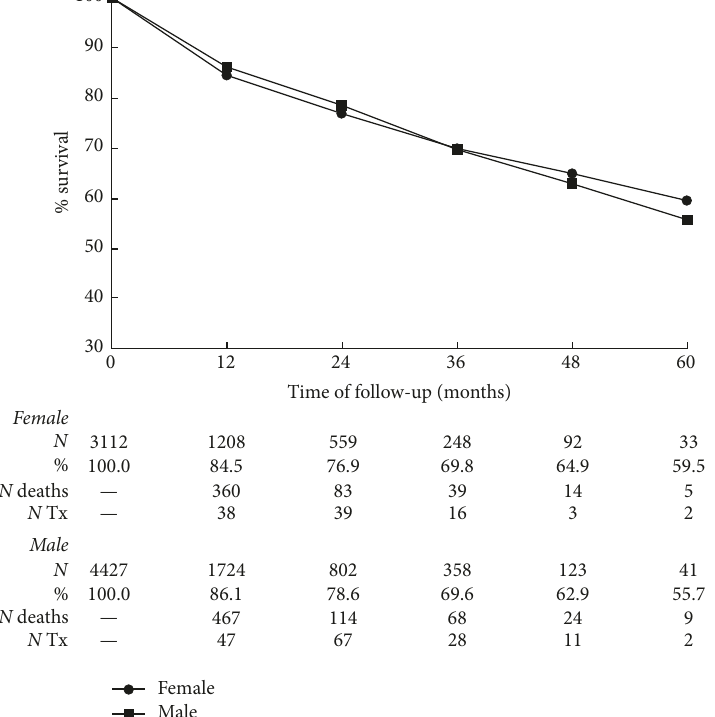
the most frequent ones. Calcium carbonate/acetate and statins were used by 17.8% and 14.4% of the patients, respec- tively (Table